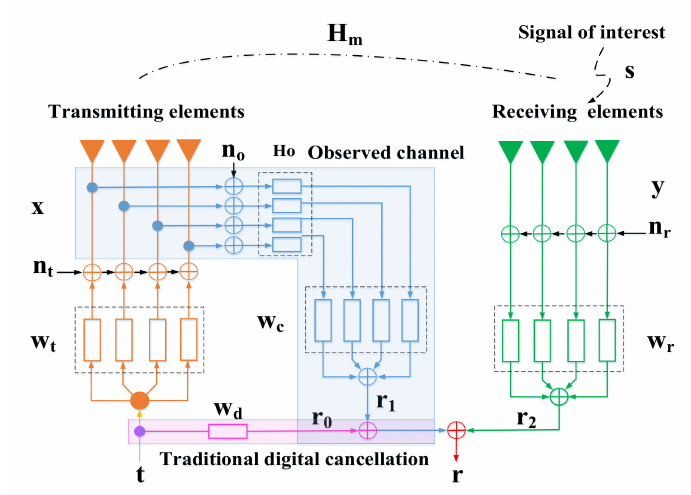
Figure 1. Block diagram of the ALSTAR array cancellation